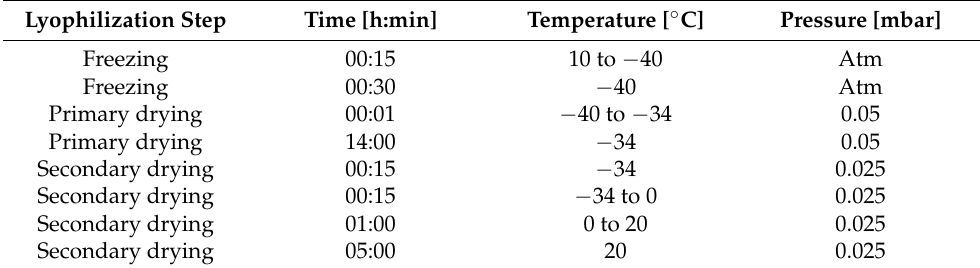
Table 2. Parameters of the standard lyophilization process